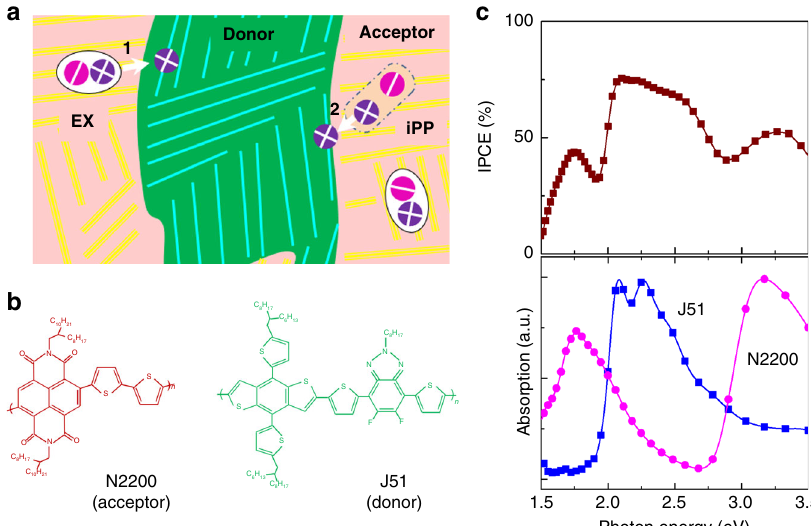
Fig. 1 Schematics of interfacial hole transfer in OPVs. a Two possible channels of hole transfer at a polymer heterojunction: (1) EX-mediated hole transfer and (2) iPP-mediated hole transfer. b Chemical structures of the polymer acceptor (N2200) and donor (J51) studied in this work. c Absorption spectra of J51 and N2200 (lower panel) are compared with the ICPE spectrum of an optimized device containing a J51/N2200 blend (upper